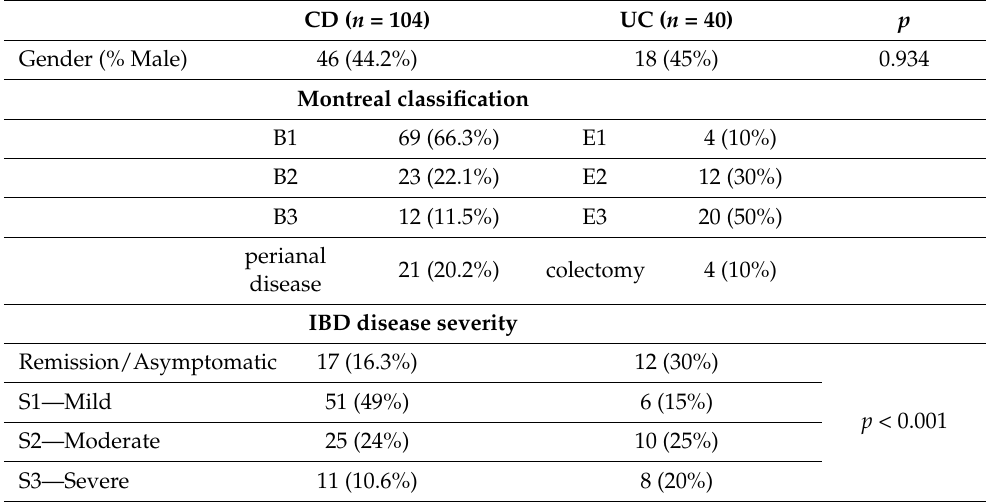
Table 1. Patient characteristics.